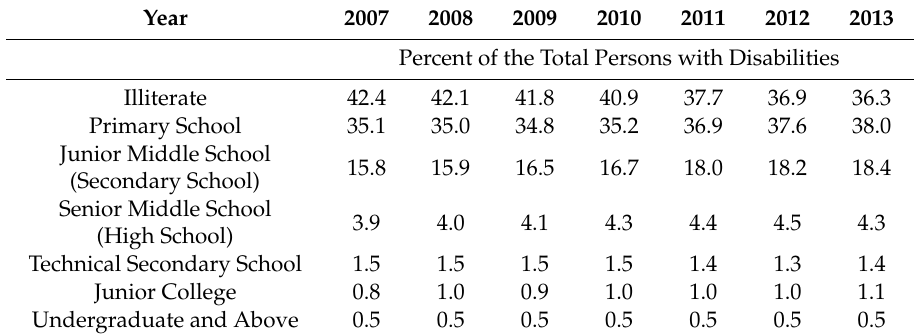
Table 2. The education level of persons with disabilities aged 18 and above in China